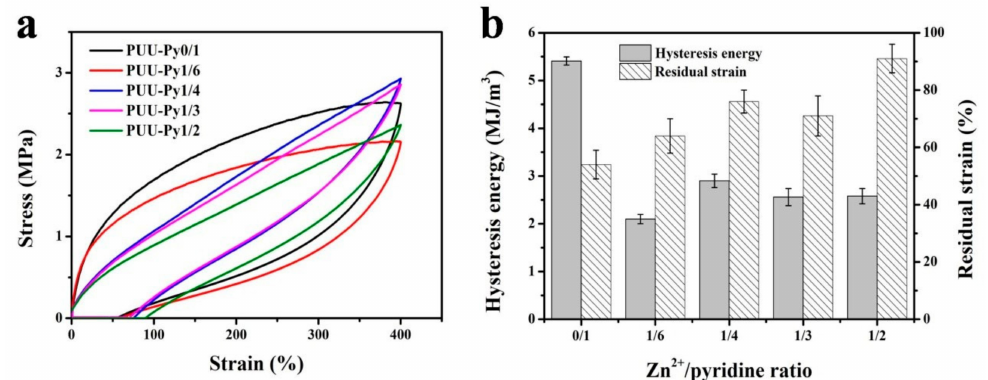
Figure 5. ( a ) Cyclic tensile curves and ( b ) hysteresis energy of PUU-Py elastomers with various Zn 2 + / pyridine ratios.